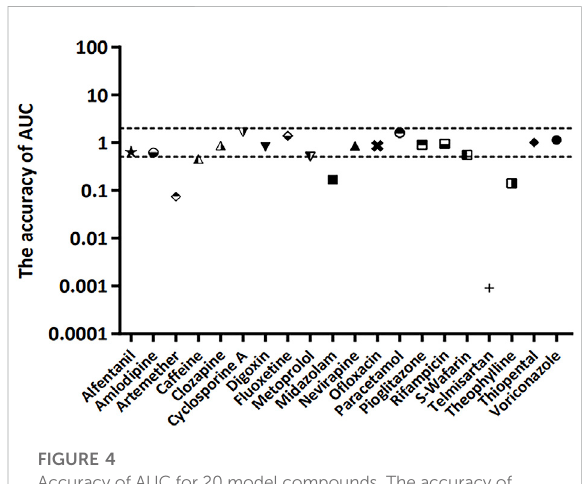
FIGURE 4 Accuracy of AUC for 20 model compounds. The accuracy of AUCwascalculatedusingEqs16,17.Thedashedlinerepresents2- fold